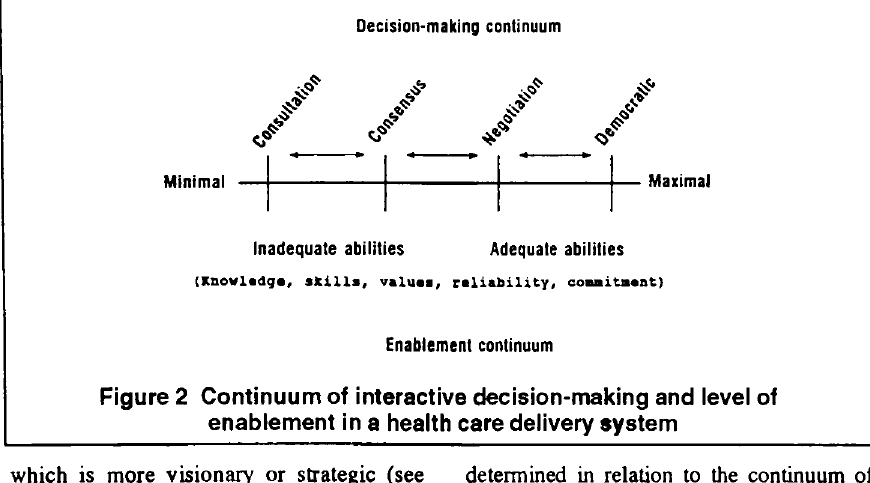
Figure 2 Continuum of interactive decision-making and level of